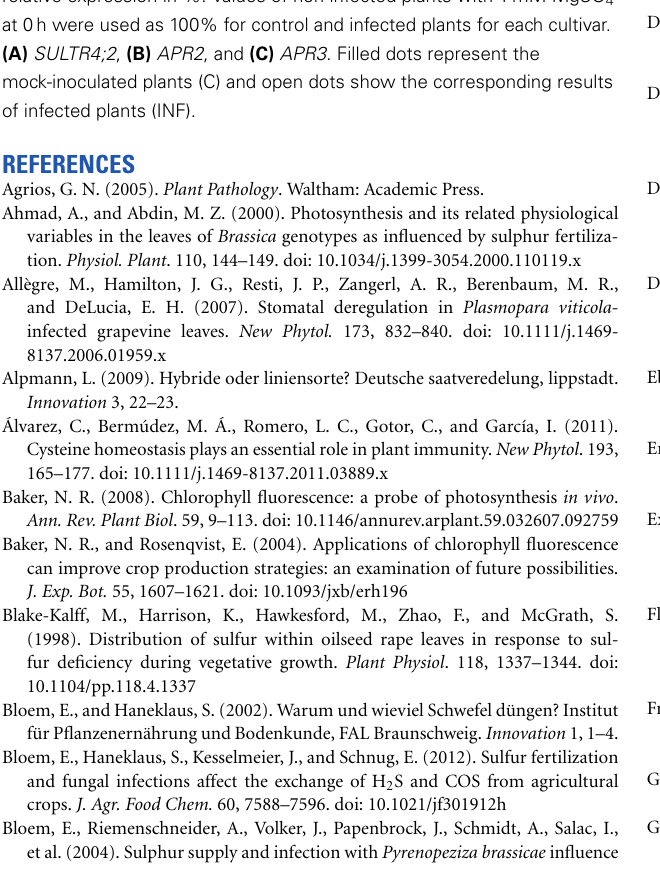
sulfur fertilization and striped bars indicate infected plants (INF). CE, catechin equivalent. Figure S3 | Expression analysis. Results of Northern Blot analysis ( Figure 10 ) were evaluated with the program GelAnalyzer (GelAnalyzer.com). Intensity for each band detected on the membrane was calculated in reference to the first sample (0h). Data represent the relative expression in %. Values of non-infected plants with 1mM MgSO 4 at 0h were used as 100% for control and infected plants for each cultivar. (A) SULTR4;2 , (B) APR2 , and (C) APR3 . Filled dots represent the mock-inoculated plants (C) and open dots show the corresponding results of infected plants